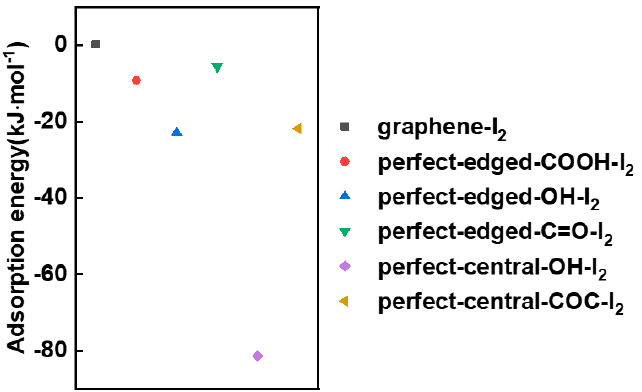
Figure 7. Adsorption energy of graphene-I 2 (C 24 H 12 -I 2 ), perfect-edged-COOH-I 2 , perfect-edged-OH-I 2 , perfect-edged-C=O-I 2 , perfect-central-OH-I 2 and perfect-central-COC-I 2 systems.